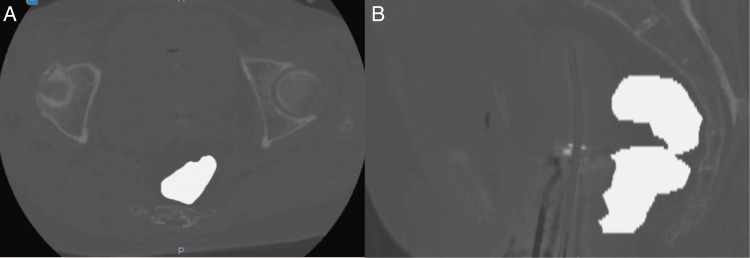
Typical CT images after replacement of internal and external CT values for the rectum and tandem/ovoid applicator. To eliminate the effects of metal artefacts on the CT images, the CT values within a rectal contour or tandem/ovoid applicator were replaced by 400 or 0 HU, respectively, and the CT values outside the rectal contours were multiplied by 0.01. Abbreviations: CT = computed tomography.